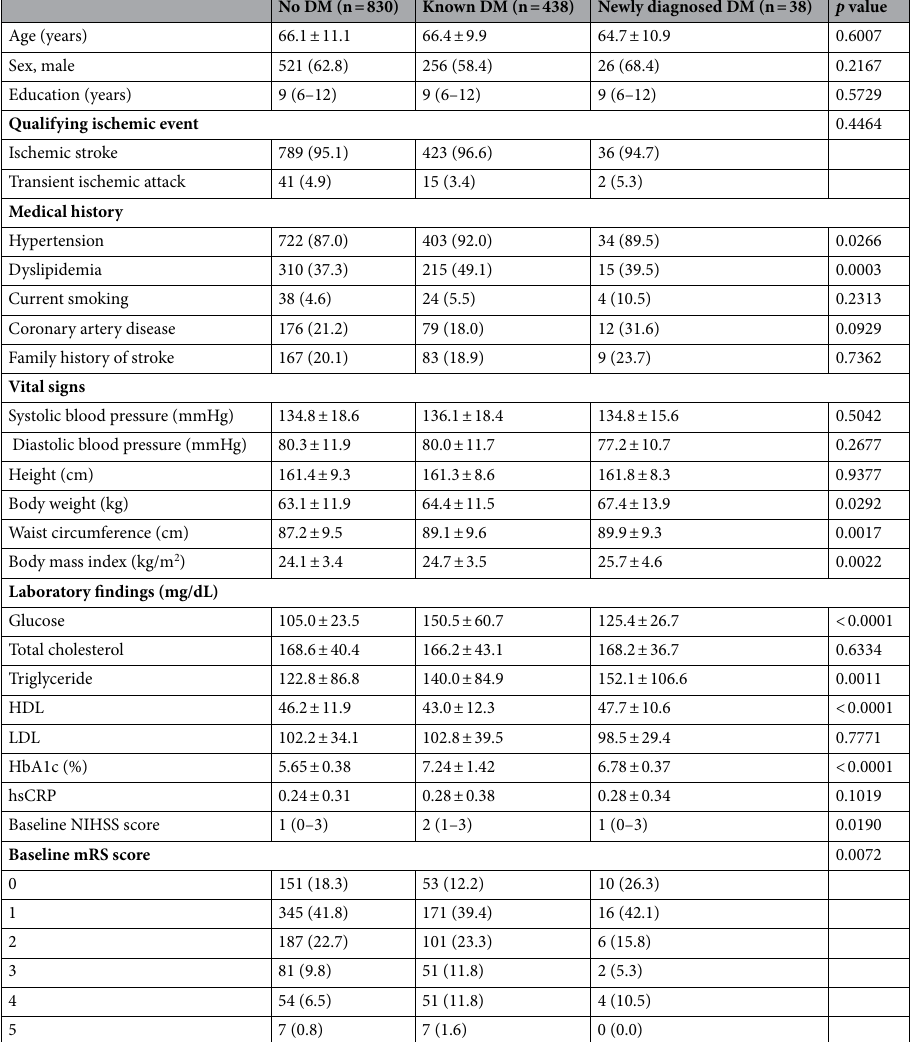
density lipoprotein cholesterol, LDL low-density lipoprotein cholesterol, hsCRP high-sensitivity C-reactive protein, NIHSS National Institute of Health Stroke Scale, mRS modified Rankin